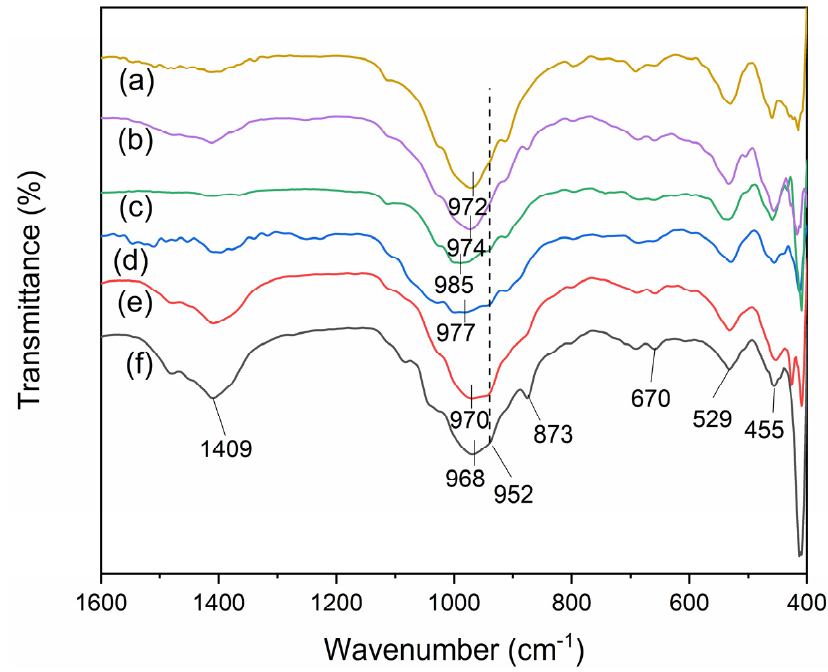
Figure 6. FT-IR spectra analysis of materials prepared with 8 M NaOH activator and different amounts of Ca(OH) 2 : ( a ) 0 g, ( b ) 15 g, ( c ) 30 g, ( d ) 45 g, ( e ) 60 g, and ( f ) 75 g. amounts of Ca(OH) 2 : (a) 0 g, (b) 15 g, (c) 30 g, (d) 45 g, (e) 60 g, and (f) 75